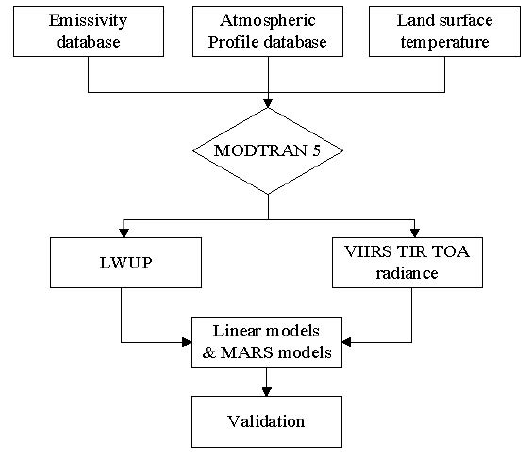
Figure 2. Flowchart for developing the hybrid method.